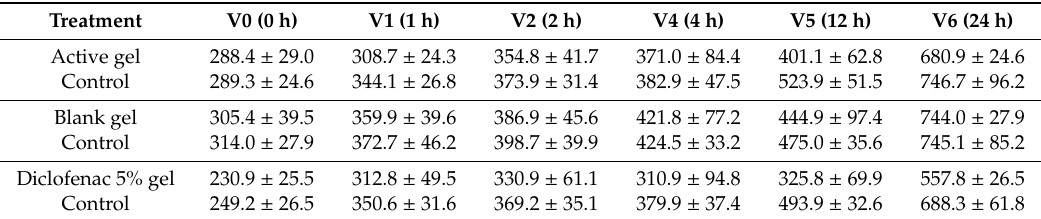
Table 3. Average paw volume in the intraplantar kaolin model.